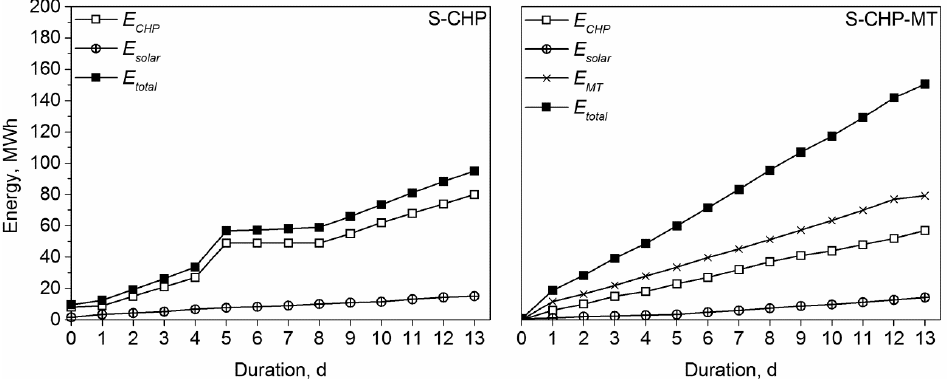
digestate in a solar greenhouse dryer with waste-heat from CHP (variant S-CHP) and additional heat from a micro turbine (variant S-CHP-MT). Mean values ± standard deviation.